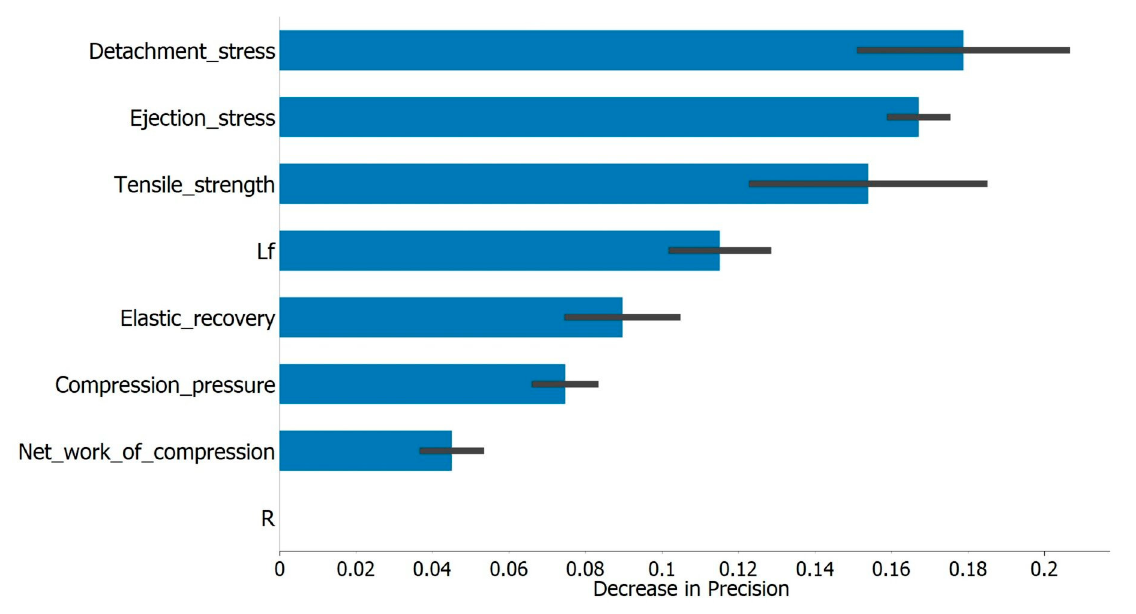
Figure 7. The influence of tested variables on classification model’s output (presented as the decrease in precision that removing a variable would cause).